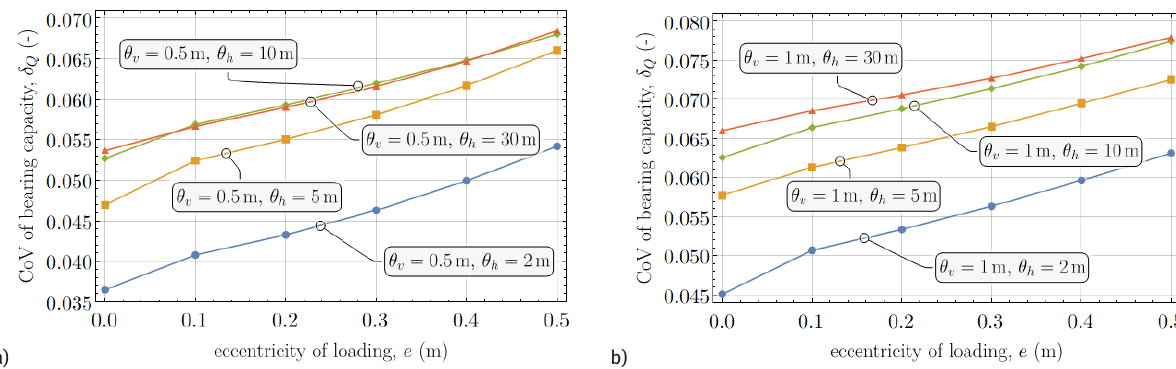
for a) θ = 0.5 m and b) θ Q v